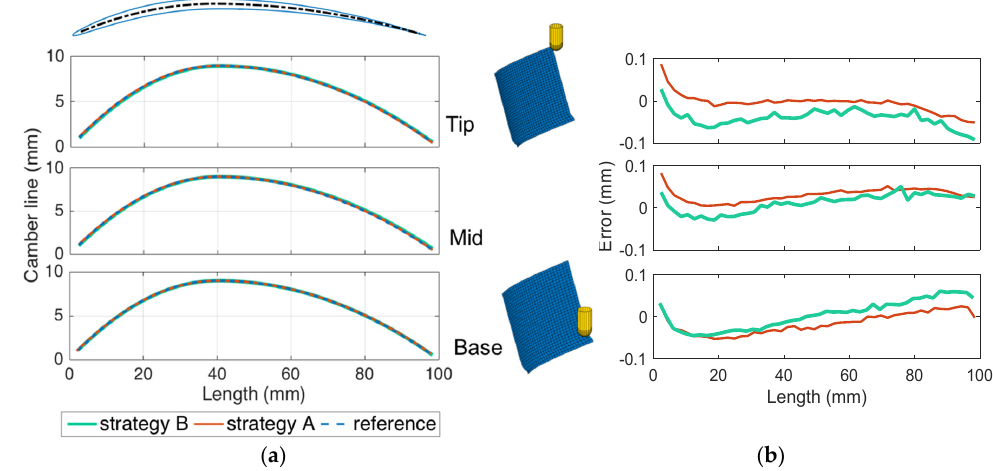
Figure 13. Camber line at different Z-level ( a ) camber line ( b ) camber line error.